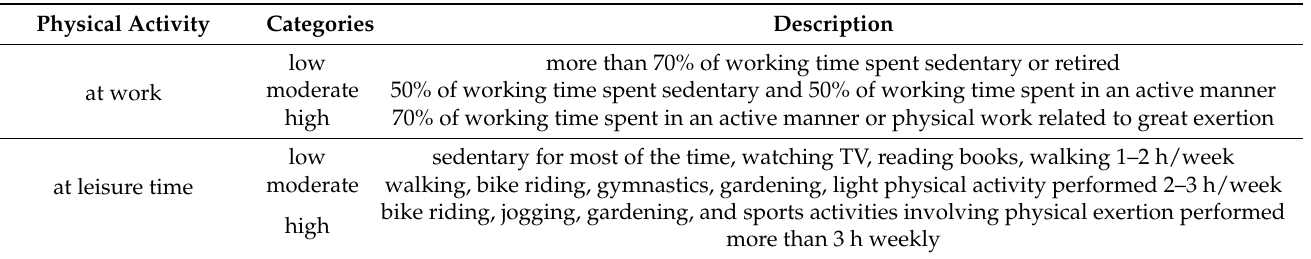
Table 2. Description of the categories of physical activity at work and in leisure